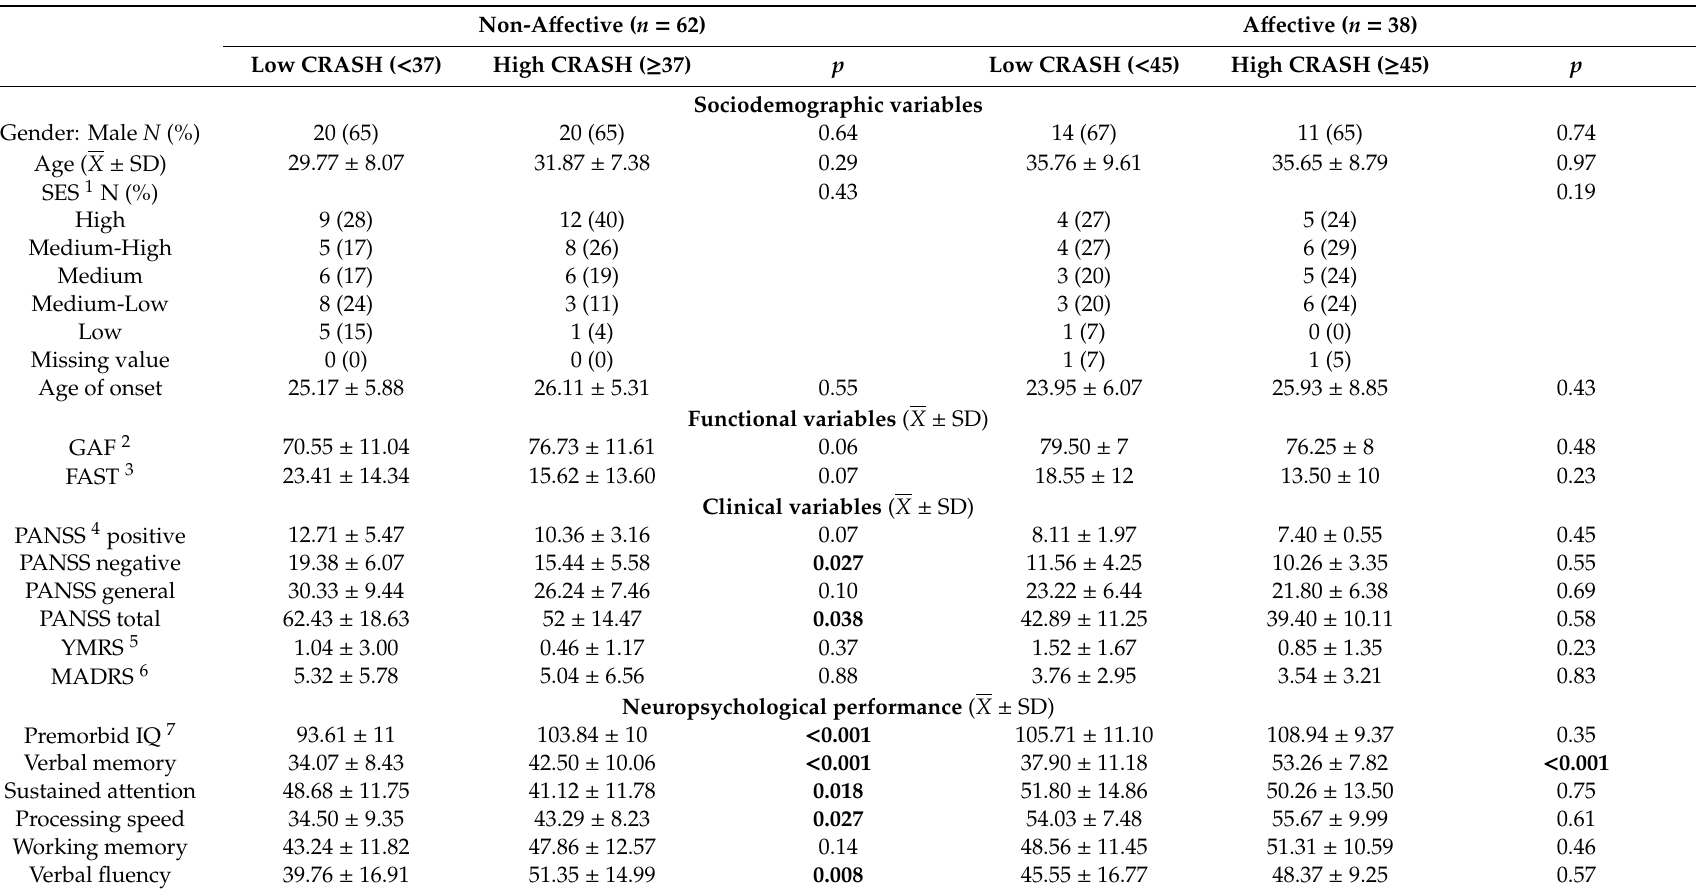
Table 5. Sociodemographic, clinical, functional, and cognitive performance among subjects with high and low CRASH